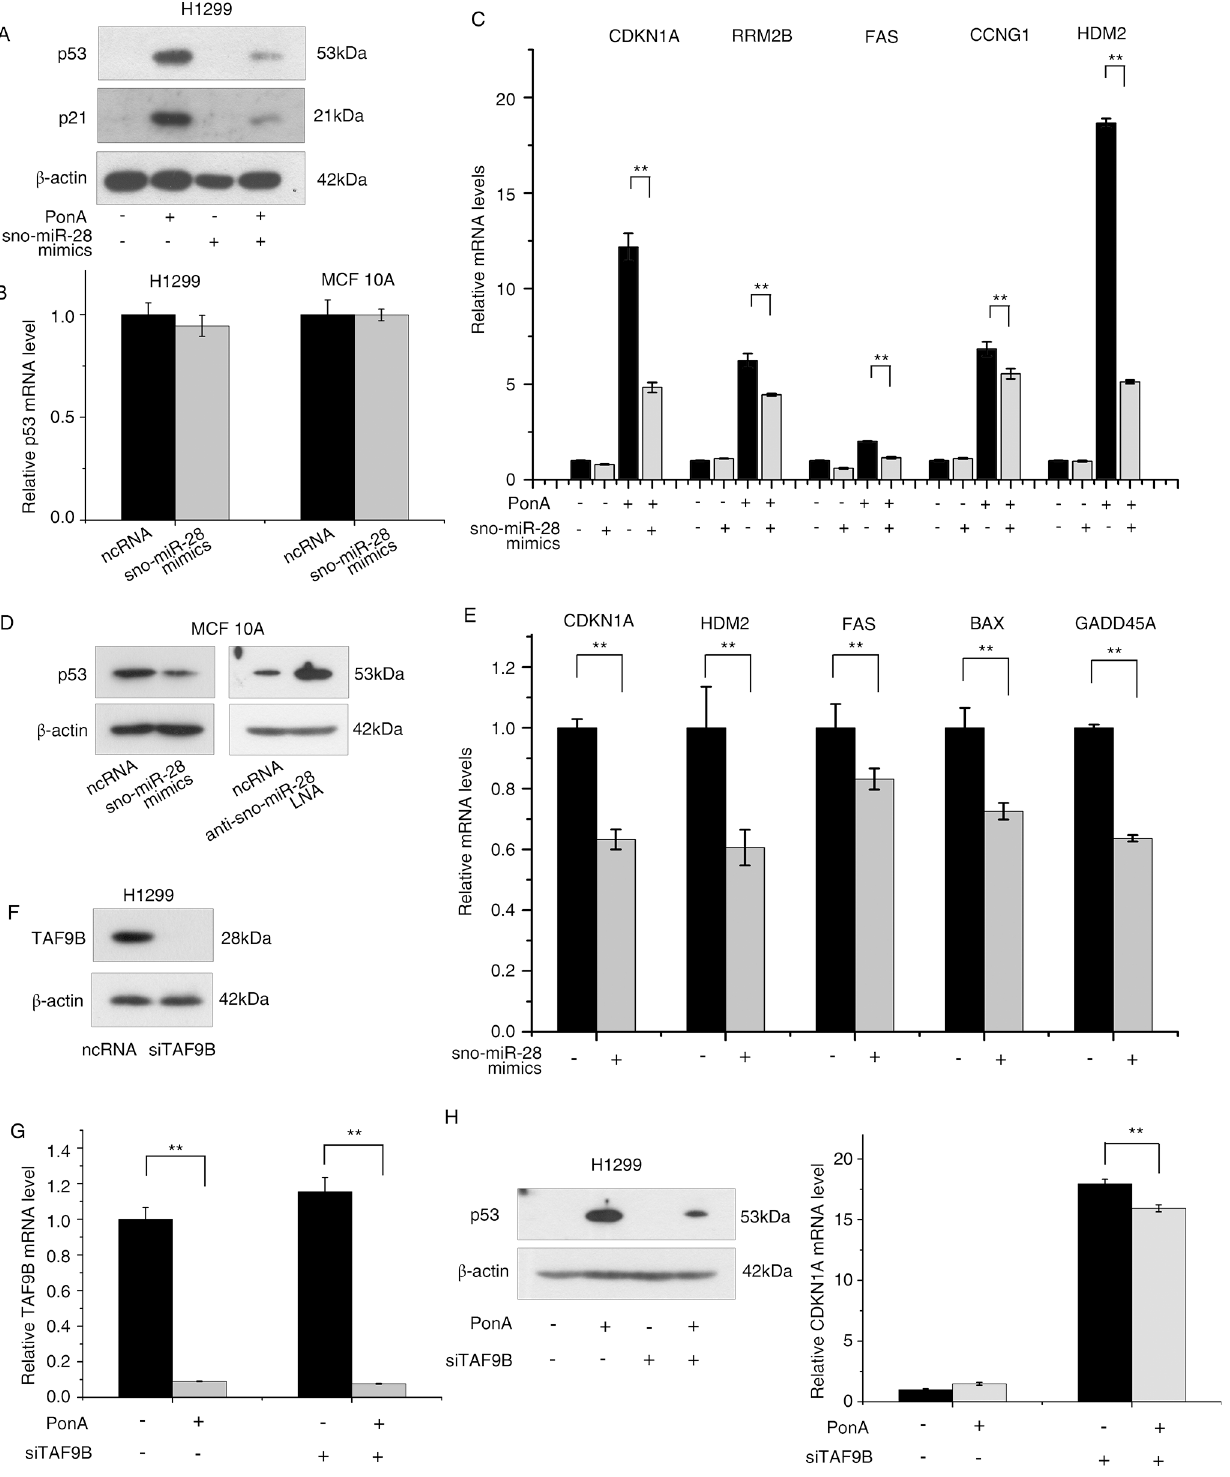
Fig 4. sno-miR-28 alters p53 protein stability through TAF9B and forms a feed-forward loop between p53, sno-miR-28, and TAF9B. (A) Western blots are shown to determine the protein levels of p53 and p21 after overexpression of sno-miR-28 and/or induction of p53 by Ponasterone A (PonA) in inducible H1299 cell line, compared with cells transfected with negative control RNA (ncRNA) and/or uninduced H1299 cells. (B) p53 mRNA levels in MCF10A and PonA-treated H1299 cells after overexpression of sno-miR-28 are shown by RT-PCR, compared with scrambled negative control (ncRNA). (C)